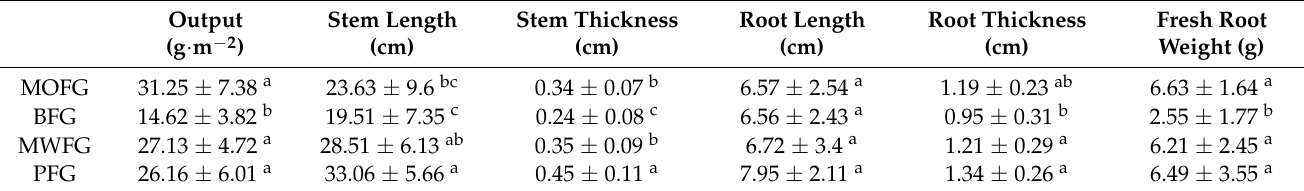
Table 2. Yield and growth status of ginseng under